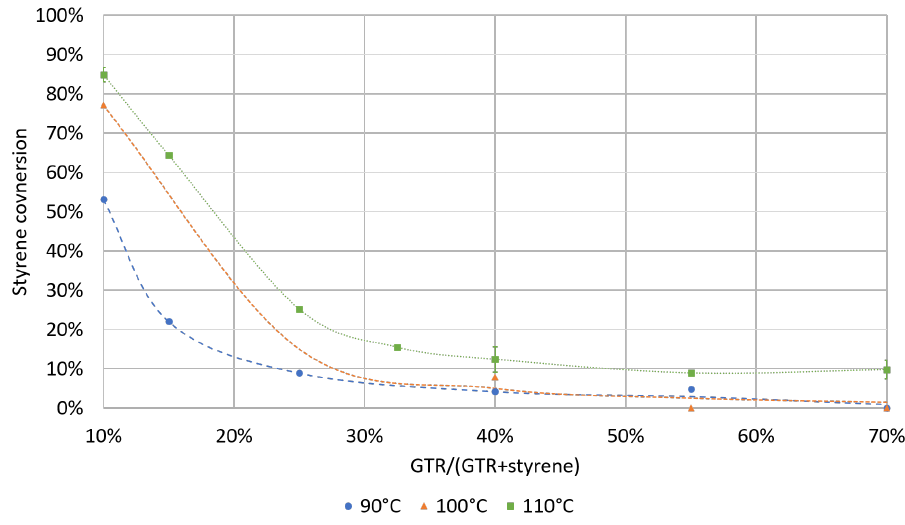
Figure 7. Effect of GTR/(GTR + styrene) and temperature for small-sized system and BPO/styrene = 5.5% (dashed curves correspond to trend